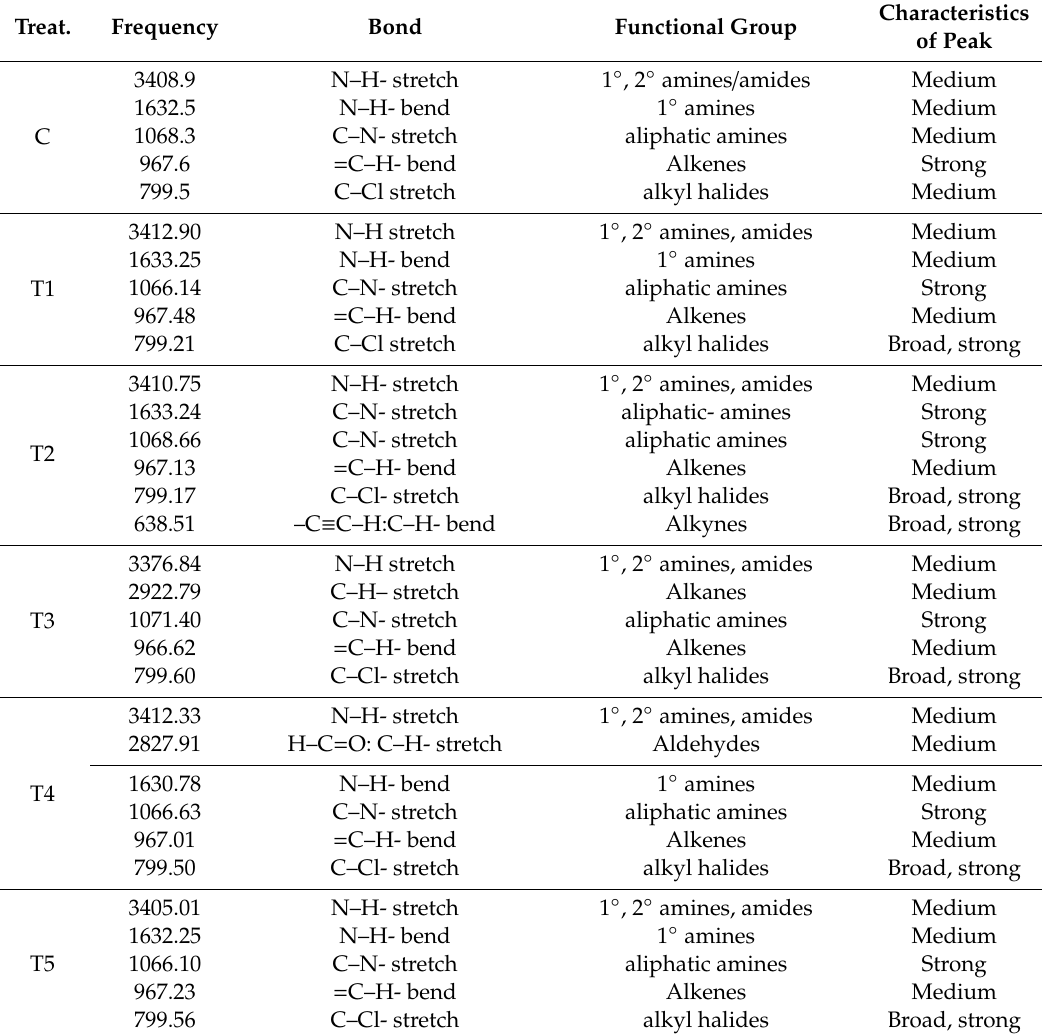
Table 2. Fourier-transform infrared spectroscopy (FTIR) of thin-layer chromatography (TLC) eluent of tomato leaves under di ff erent